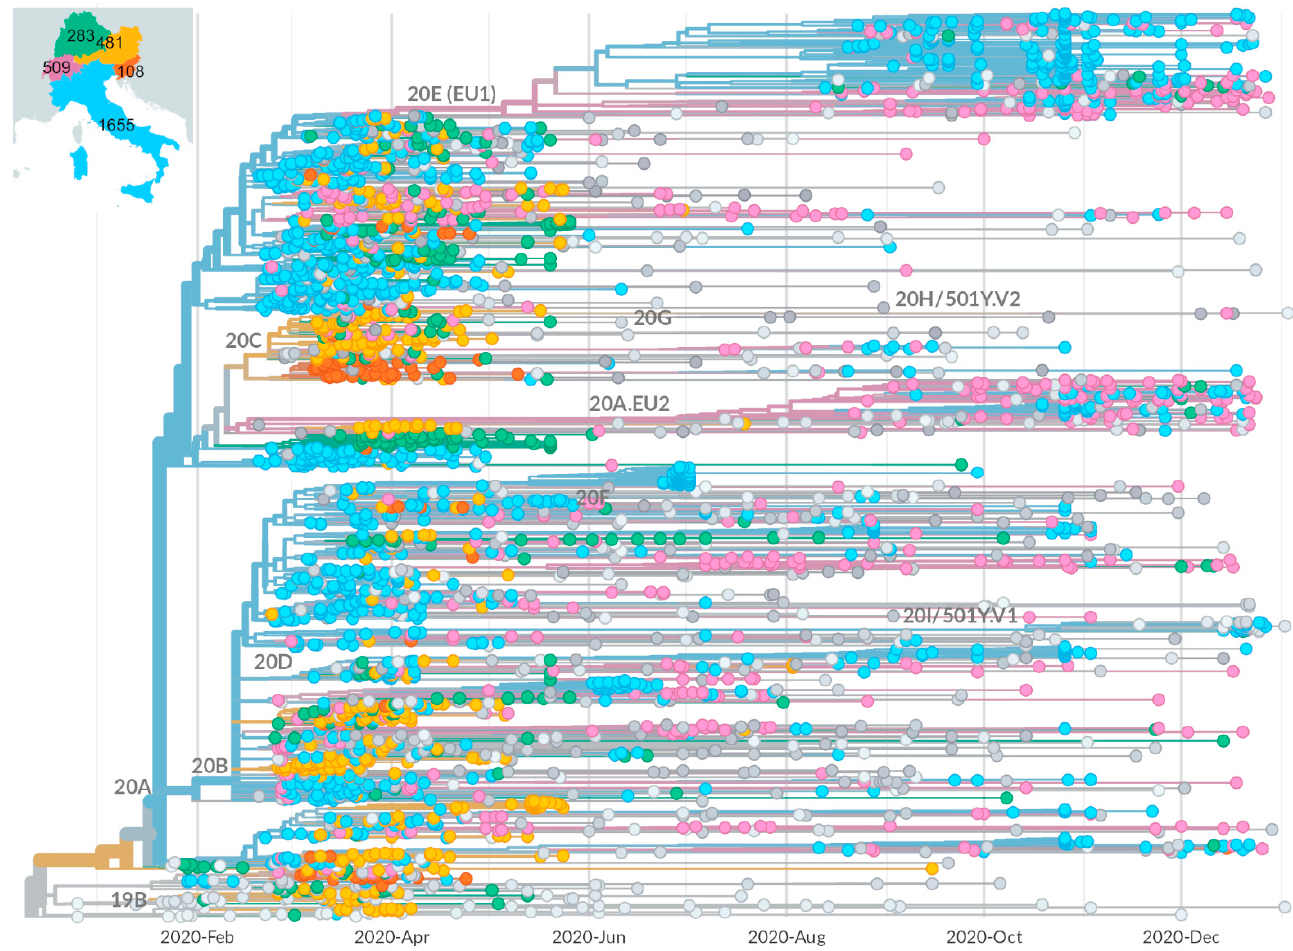
Figure 1. Phylogenetic analysis of the 2020 dataset. The analysis is focused on viral sequences from Italy and neighboring countries, sampled during 2020. The number of samples from each country of the focus is reported in the inset. The samples in the tree are colored on the basis of their origin, according to the colors used in the inset; the samples in gray are additional from the rest of the world, added to ensure the presence of all major globally spread virus subpopulations. The occurrence of known clades is indicated by the labels near the top node of the corresponding sub-tree. Bottom bars indicates time periods in which the Italian government implemented stringent (black) or relaxed (gray) mobility restrictions.